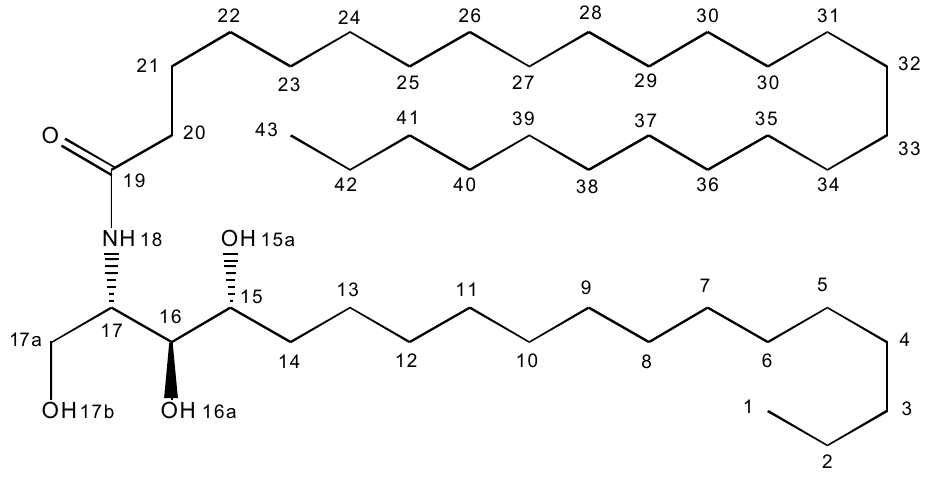
Figure 5. Negative ion sheath flow ESI mass spectrum of reaction A mixture. [M − H] − is observed for residual hexacosanoic acid, hexacosanoylceramide product, and the cluster species [hexacosanoic acid + hexacosanoylceramide − H] − .